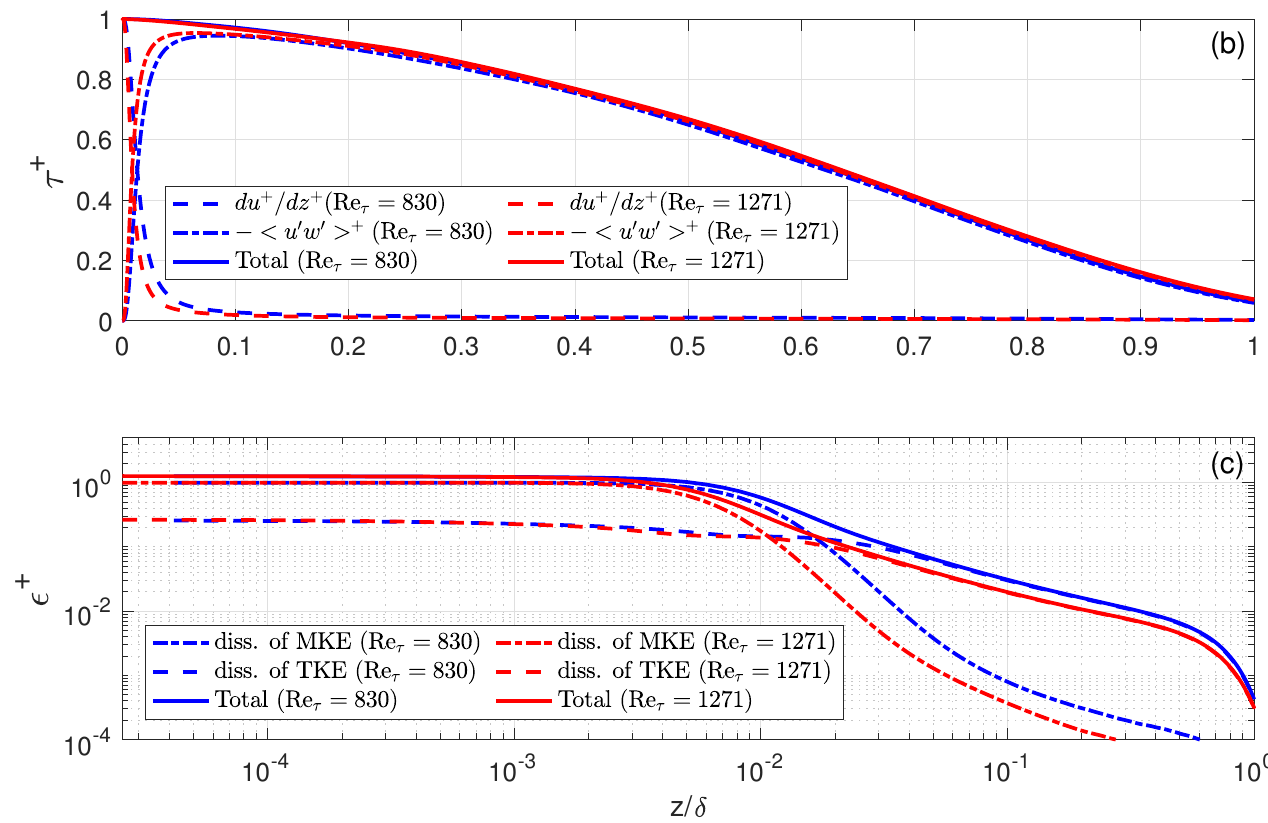
Figure 2. Profiles of non-dimensional velocity ( a ), shear stress including both viscous stress du + /dz + and Reynolds stress < u 0 w 0 > + ( b ) and dissipation rate ( c ) as a function of z / δ (depth normalized by the boundary layer thickness) in the DNS of non-rotating BBL.